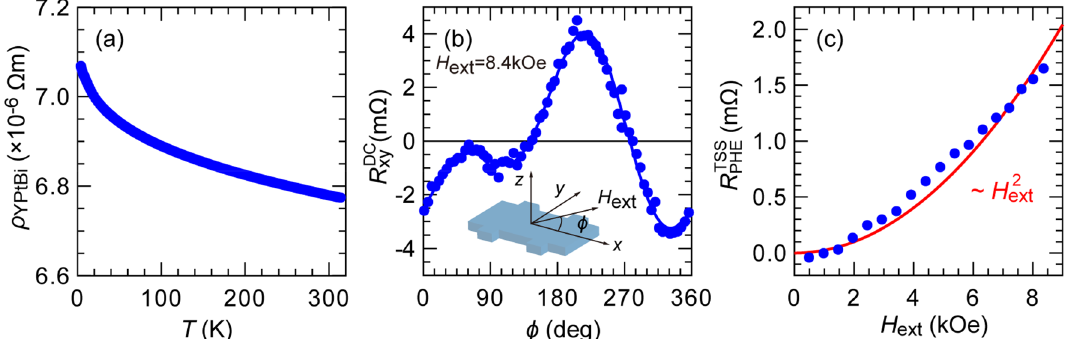
Figure 3. ( a ) Temperature dependence of the resistivity of a 11.8 nm-thick YPtBi film. ( b ) Planar Hall resistance measured with an in-plane rotating H ext of 8.4 kOe measured at 4 K, where dots are experimental data and the solid curve is a fitting given by Eq. (1). Inset shows the coordination system and definition for the azimuth angle ϕ of H ext . The sin2 ϕ dependence of the Hall resistance originates from the spin-momentum locking of TSS. ( c ) Amplitude of the sin2 ϕ planar Hall resistance as a function of H ext , which increases as H ext2 , similar to those observed in